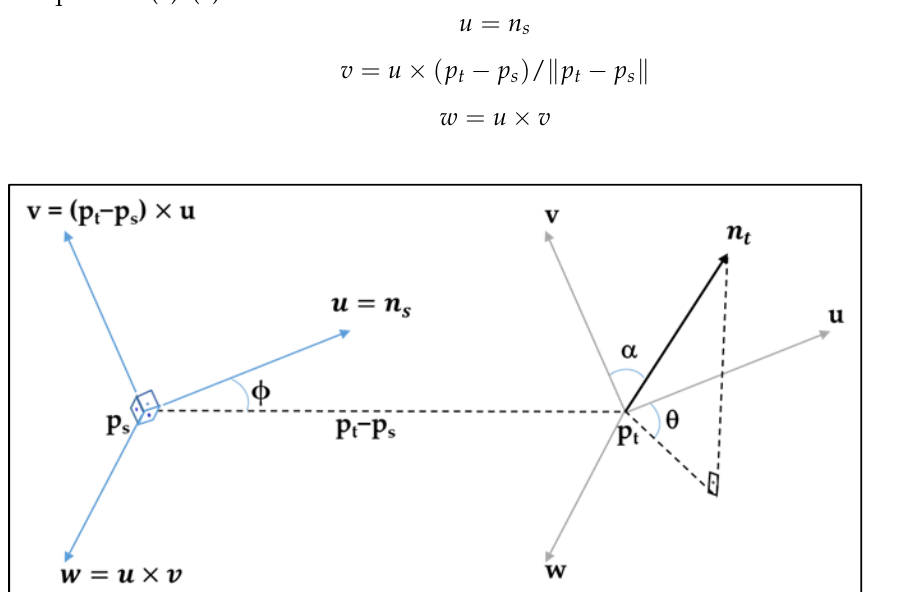
Figure 6. Darboux frame between a point pair (adapted from [38]).